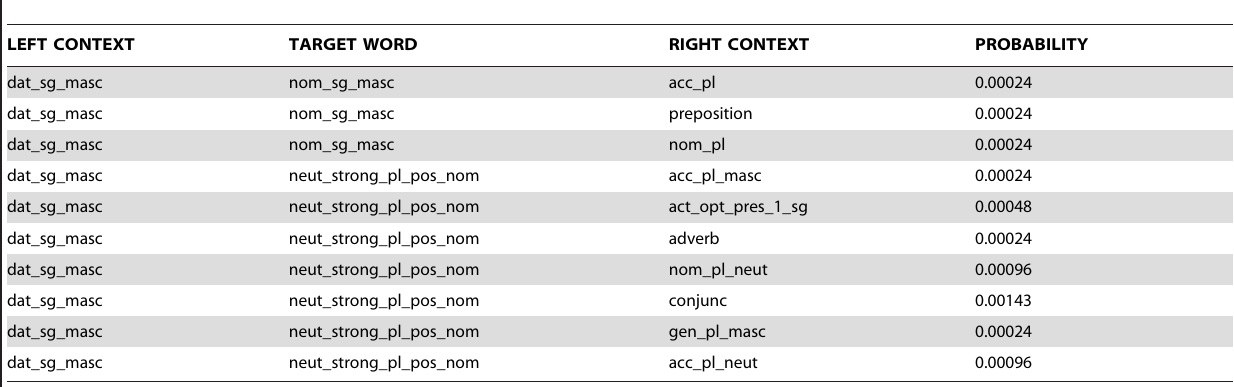
Table 5. Probabilities for given target words using context feature window size =3.